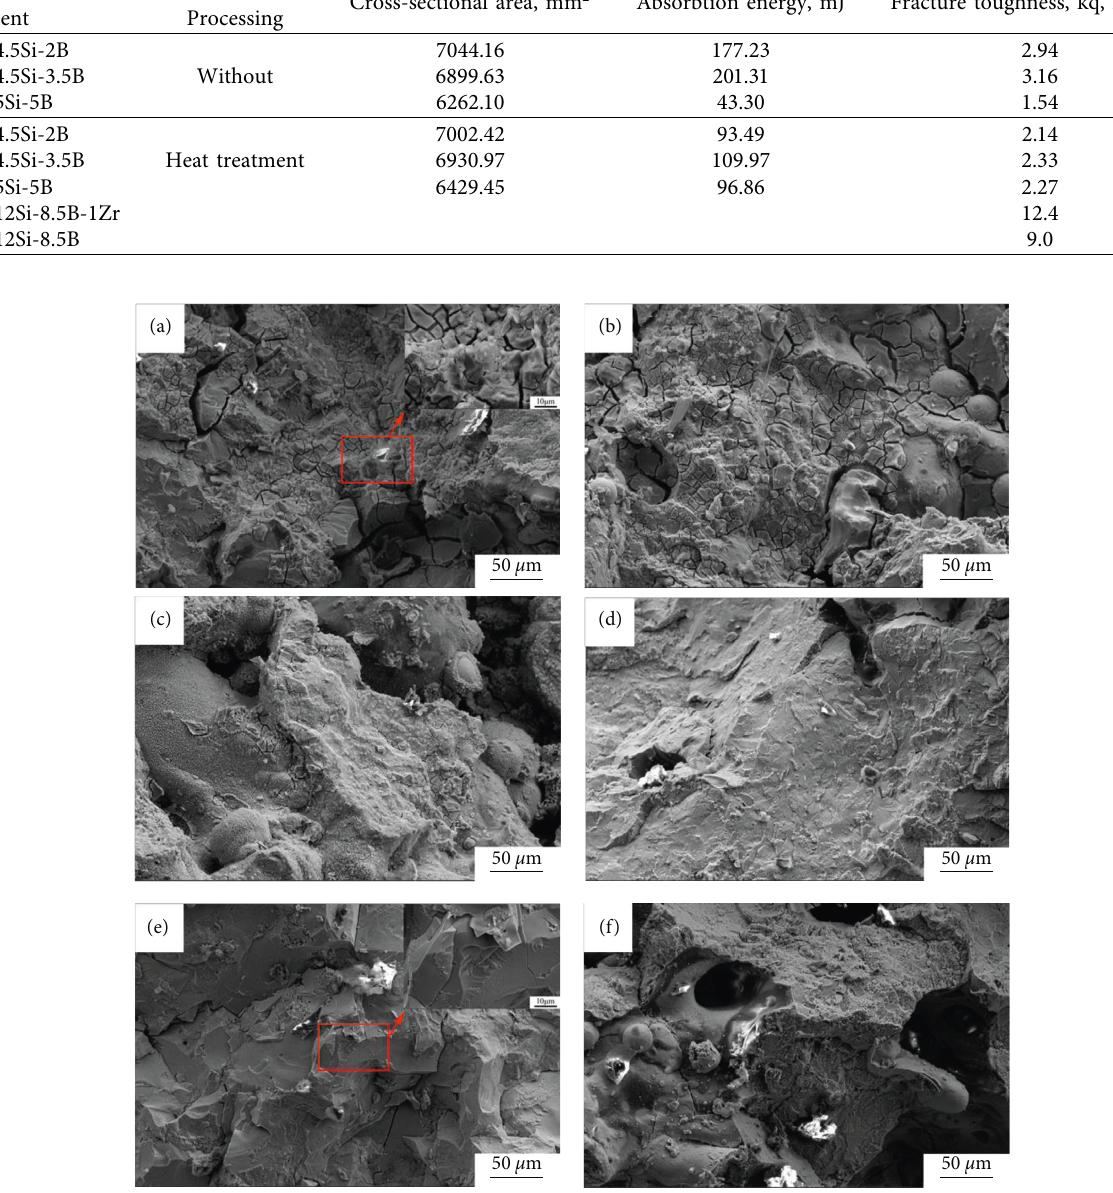
Figure 6: Fracture before heat treatment: (a) Mo-4.5Si-2B and (b) Mo-4.5Si-3.5 B. After heat treatment: (c) Mo-5Si-5B, (d) Mo-4.5Si-2B, (e) Mo-4.5Si-3.5 B, and (f)